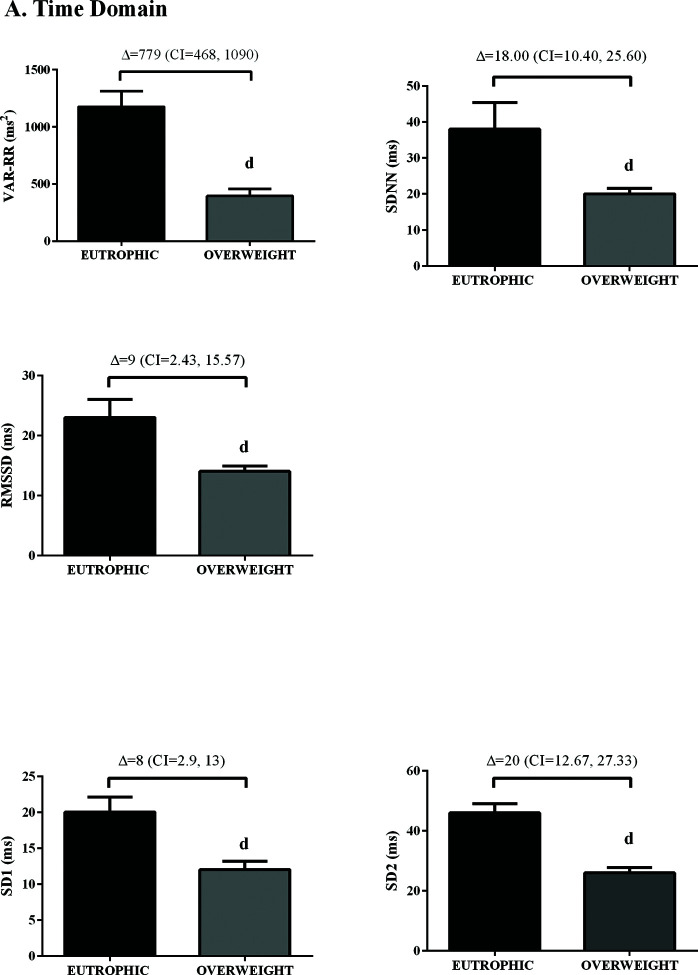
Values are presented as mean±standard deviation or adjusted mean difference (95% confidence interval). Unpaired t-test; dp<0.05 vs. euthrophic.